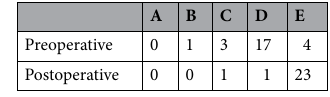
Table 1. Frankel